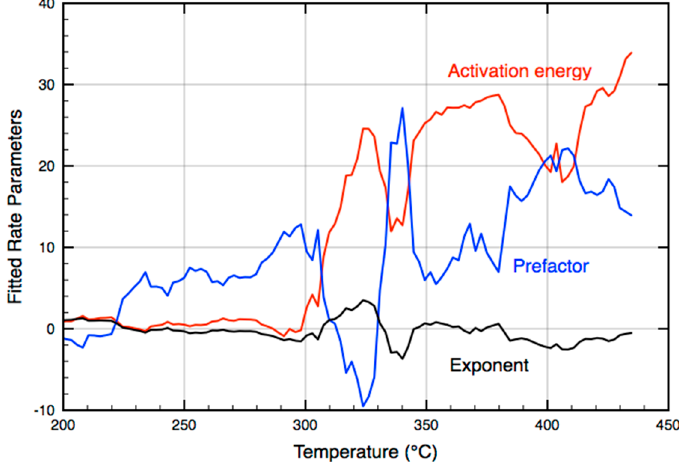
Apparent activation energies, E T (red line), prefactors, ln A T (blue line) and exponent, n T (black line) as a function of temperature for the evolution of methacrolein during temperature-programmed oxidation of isobutane over phosphomolybdic acid (3 rd run).